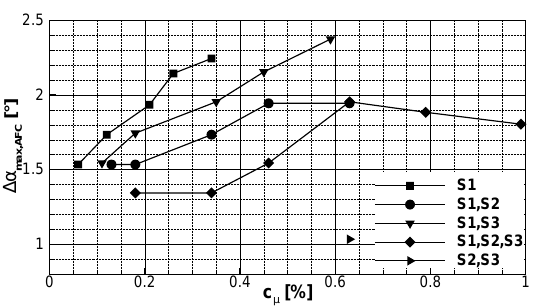
Figure 16. Stall angle offset for different momentum coefficients and segment combinations.